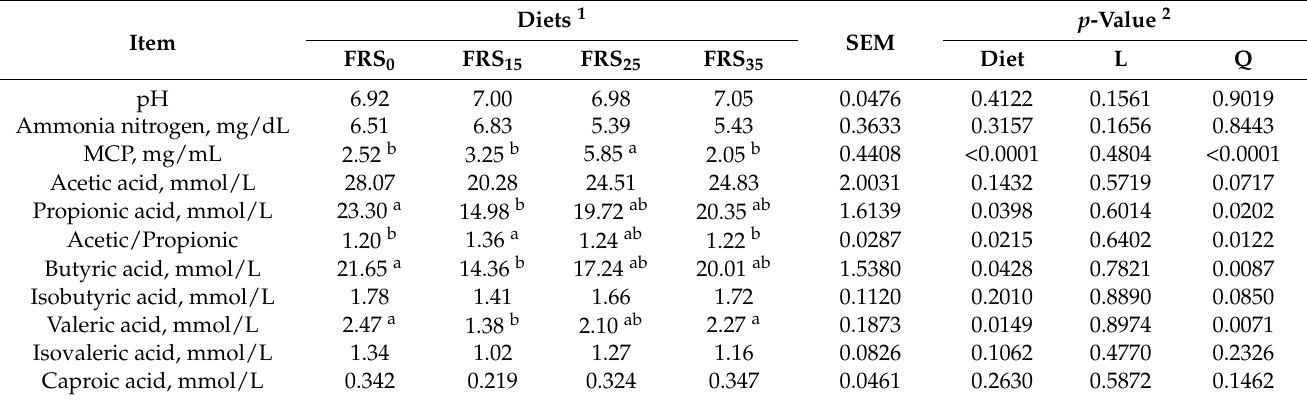
Table 4. Rumen fermentation characteristics in lactating buffaloes fed the four experimental diets.